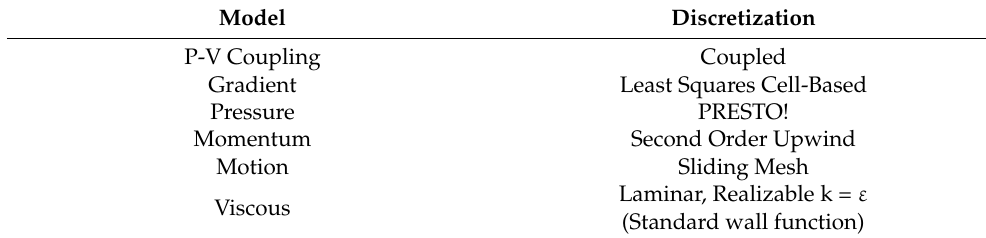
Table 1. Fluid simulation settings.